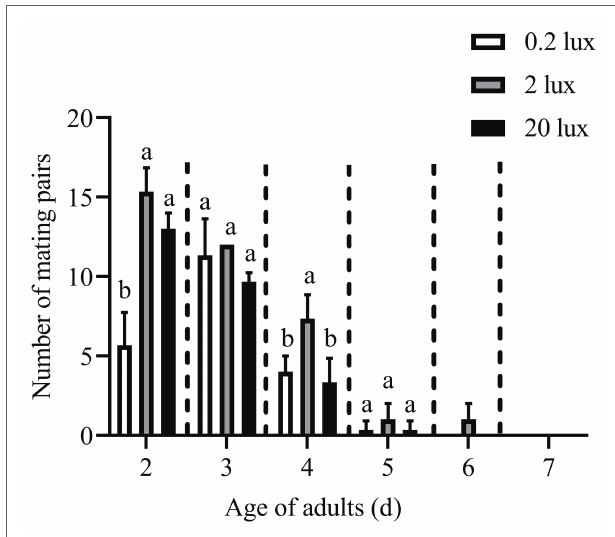
FIGURE 4 | Mating pairs of C. punctiferalis under different intensities of red light during scotophase. Data are shown as mean ± standard deviation, from three replicates. Different letters above columns mean significant differences ( p < 0.05, ns: no significant difference), by Tukey’s multiple comparisons after